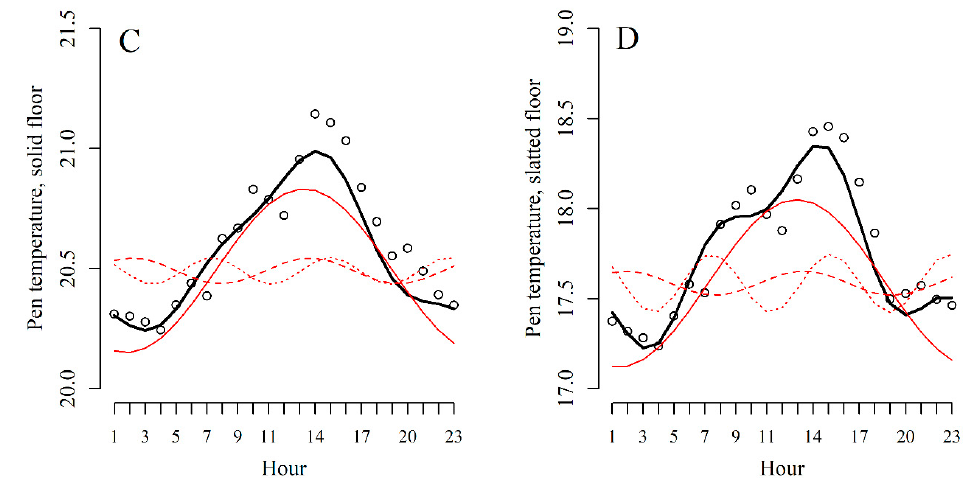
Figure 2. Diurnal pattern of ( A ) water flow, ( B ) activation frequency, ( C ) pen temperature above the solid floor and ( D ) pen temperature above the slatted floor, averaged across all days of the study. Circles: mean observation of the raw data for each hour. Thin red lines: the model-estimated three harmonic waves with 24-h (—), 12-h (- - -) and 8-h ( ···· ) cycles. Thick black line: the model-estimated sum of the three harmonic waves. No recordings were available on pen temperature for the first hour of the day (hour